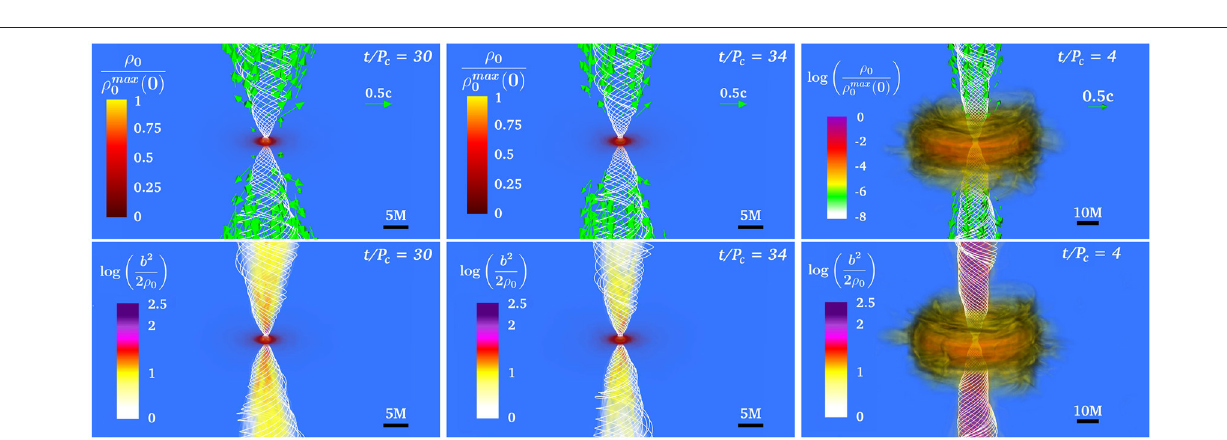
FIGURE 12 | Final profiles of the rest-mass density ρ 0 normalized to the initial maximum density (top) , and the force-free parameter inside the helical magnetic funnel (bottom) for a standard HMNS (left), an ergostar (middle row), and BH + disk (right). White lines depict the magnetic field lines, while the arrows display fluid velocities. P c is the rotation period measure at the point where the rest-mass density is maximum. Here M = 5.9 km and b 2 = B 2 / 4 π . (from Ruiz et al.,